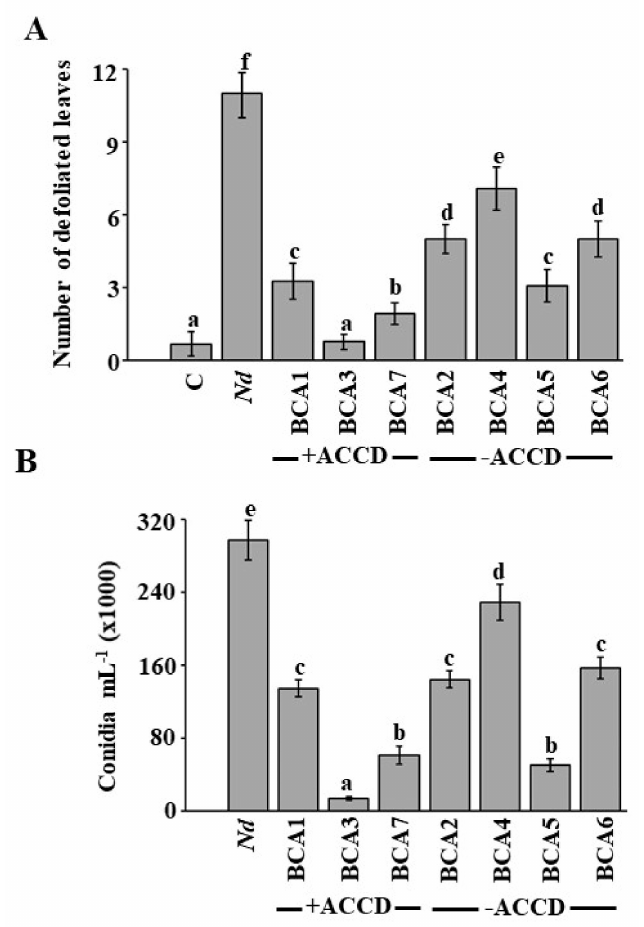
Figure 2. Effect of the application of selected Streptomyces spp. on royal poinciana stem canker disease under greenhouse conditions. Preliminary results of BCA treatments on ( A ) number of defoliated leaves of inoculated seedlings; and number of ( B ) conidia after the recovery of the pathogen from affected stem tissues after five wpt. In ( A , B ), values with different letters are significantly different from each other at p < 0.05. Bars represent standard errors. Royal poinciana seedlings were inoculated with the individual isolate one week prior to Neoscytalidium dimidiatum inoculation. BCA1, BCA3 and BCA7 are ACCD-producing isolates (+ACCD), whereas BCA2, BCA4, BCA5 and BCA6 are ACCD-non-producing isolates ( − ACCD). C, non-inoculated control seedlings, Nd , seedlings inoculated with N. dimidiatum only; BCA, biological control agent; ACCD, 1-aminocyclopropane-1- carboxylic acid deaminase; wpt, weeks post treatment. Isolates #21 (BCA3) and #45 (BCA5)